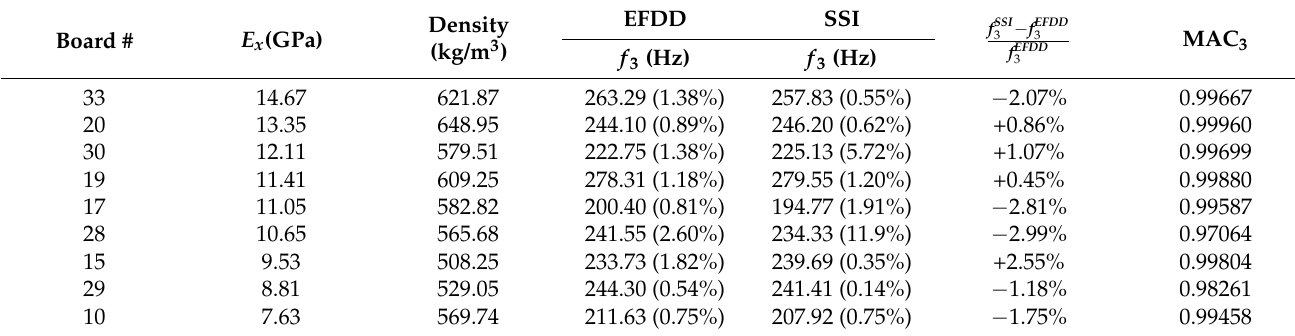
Table 4. Comparison of third resonant frequency and modal shape obtained with EFDD and SSI methods in different timber